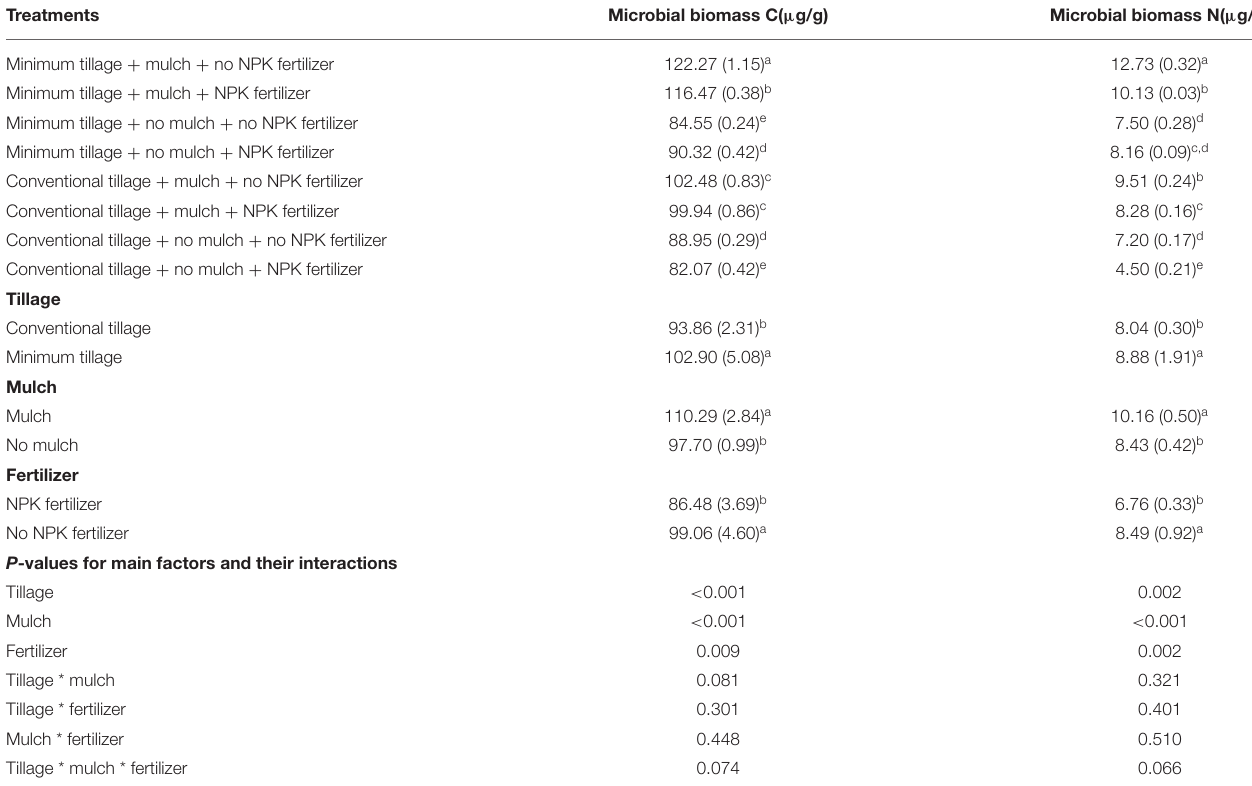
TABLE 1 | Soil microbial biomass C and N as influenced by tillage, mulch and inorganic fertilization, and their interactions.